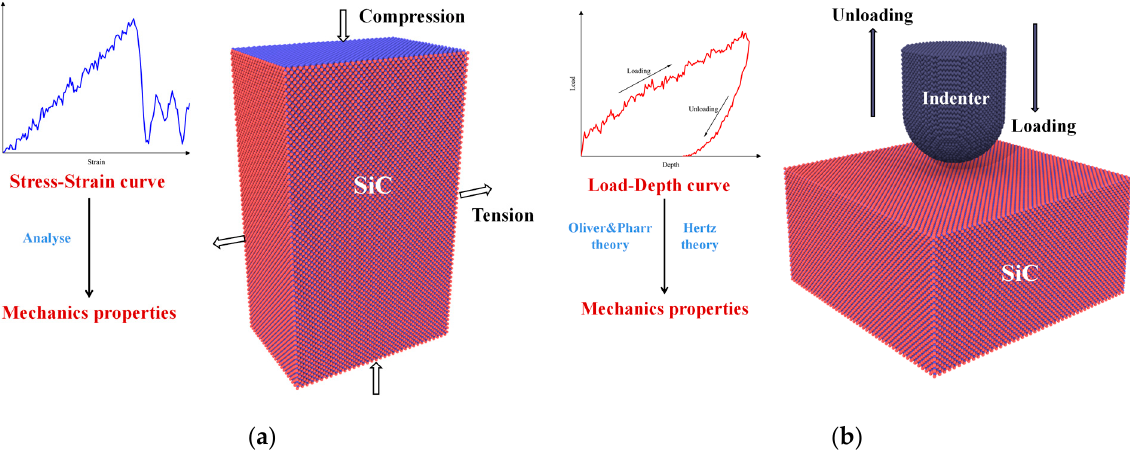
Figure 3. The typical mechanical properties calculation model of SiC: ( a ) Uniaxial ten- sile/compression; ( b ) Nanoindentation